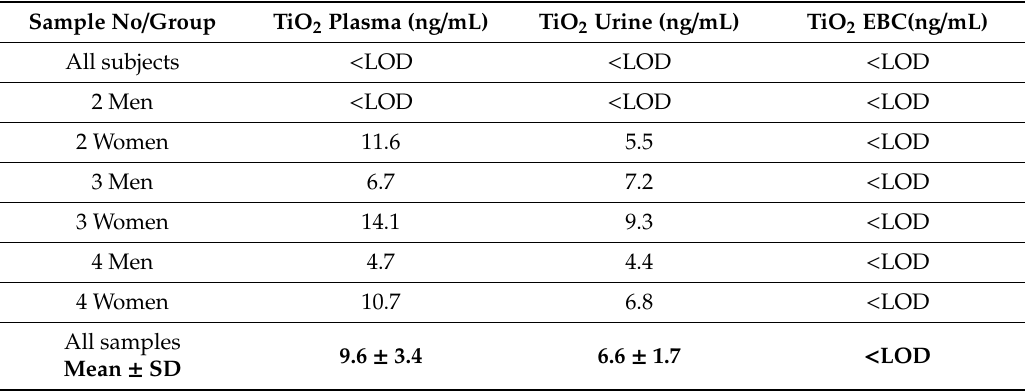
Table 3. TiO 2 concentration measured in plasma, spot urine, and exhaled breath condensate (EBC)